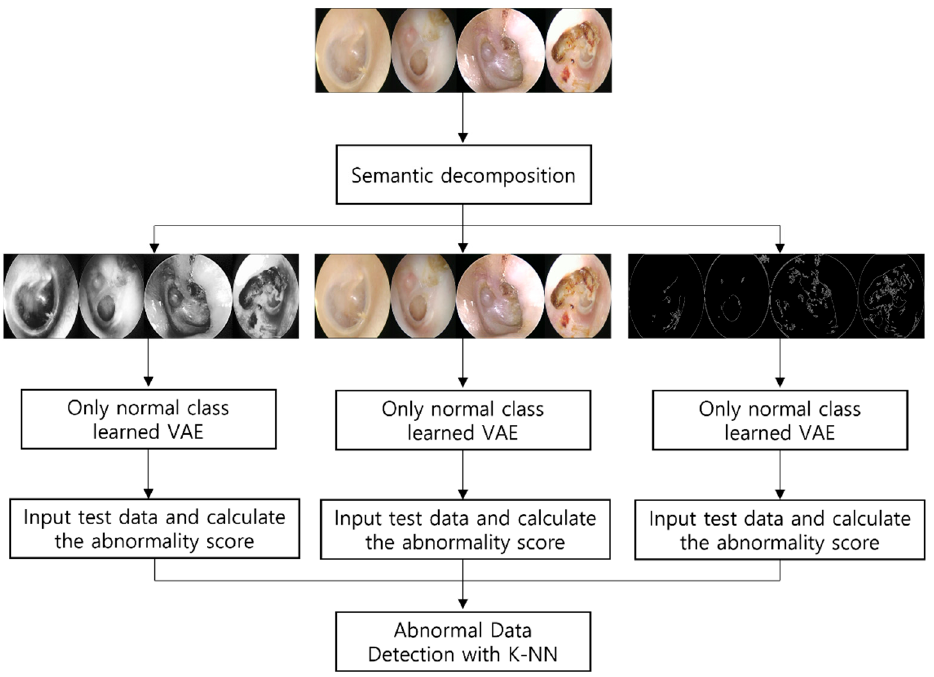
Figure 1. Overview of semantic decomposition of endoscopic data and anomaly detection methods using VAE.